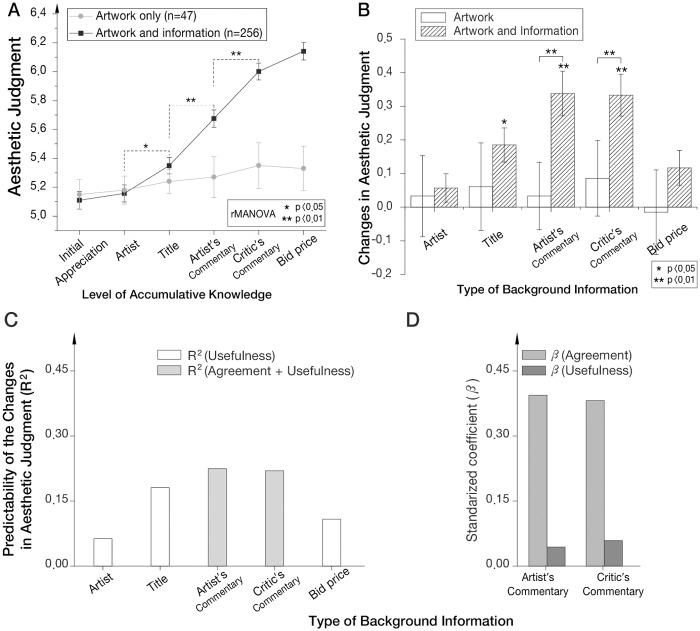
Behavioral changes in aesthetic judgment as a function of the background information.(A) Sequential changes in self-reported aesthetic judgments through the incremental learning of background information. (B) Influence of each type of background information. Each bar denotes an increase in aesthetic judgment compared to the judgment made prior to being exposed to each piece of information. The changes in aesthetic judgment after being exposed to the title information, the artist’s commentary, and the critic’s commentary were significant (repeated measures ANOVA; *: P < 0.05; and **: P < 0.01). (C) The correlation coefficient (R-squared) between the subjective assessment of each type of background information and changes in aesthetic judgments (P < 0.001). (D) The value of the standardized coefficient β indicates the power of the increases in the agreement with (light gray) and usefulness of (gray) the commentary to predict increases in aesthetic judgments (multiple regression analysis; P < 0.001). The error bars represent the standard error of the mean (SEM).